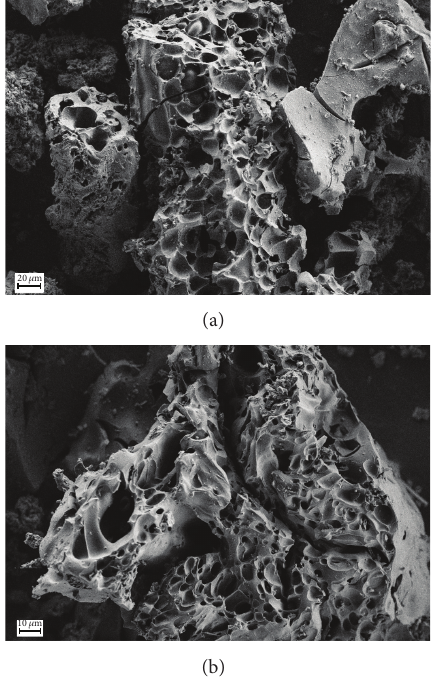
F 6: FESEM micrograph for bamboo biomass: (a) carboniza- tion and (b) dehydration (chemical) routes.